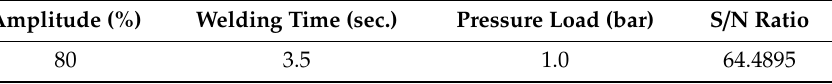
Table 6. Optimal welding conditions and S / N